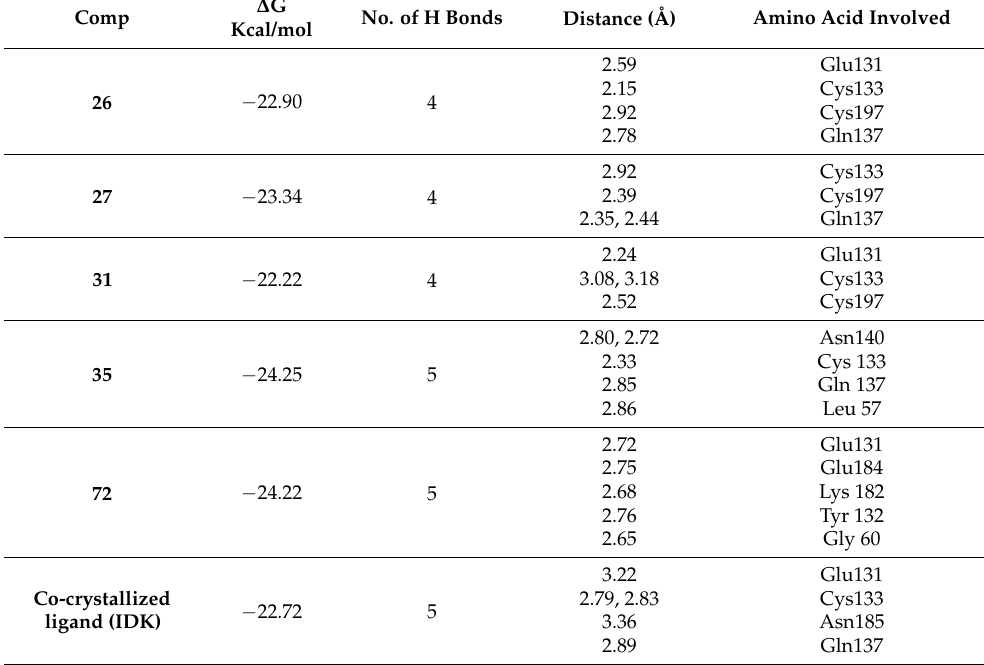
Table 3. Calculated ∆ G, amino acid interactions, and distances for the best five candidates and co-crystallized ligand (IDK) against BMP-2-inducible kinase ( ∆ G in Kcal/mol). ∆ G Comp No. of H Bonds Distance (Å) Amino Acid Involved Kcal/mol